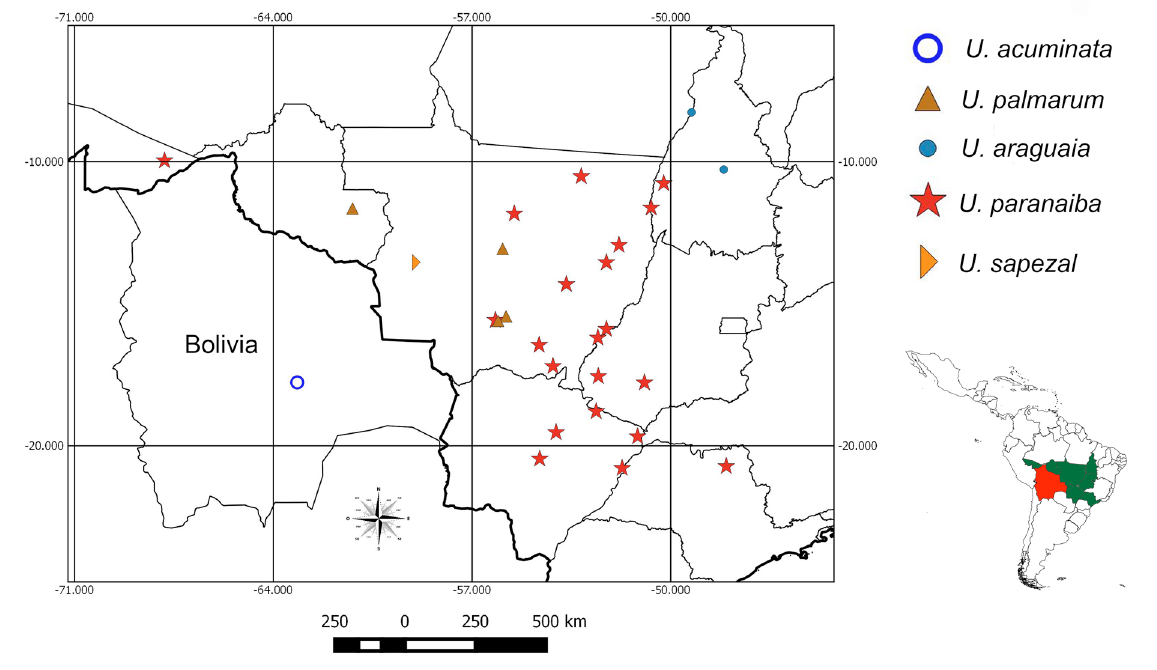
Fig. 30. Geographic distribution records of species of Umbyquyra gen. nov.: U. acuminata (Schmidt & Tesmoingt in Schmidt, 2005) gen. et comb. nov., U . palmarum (Schiapelli & Gerschman, 1945) gen. et comb. nov., U . araguaia gen. et sp. nov., U . paranaiba gen. et sp. nov. and U . sapezal gen. et sp.